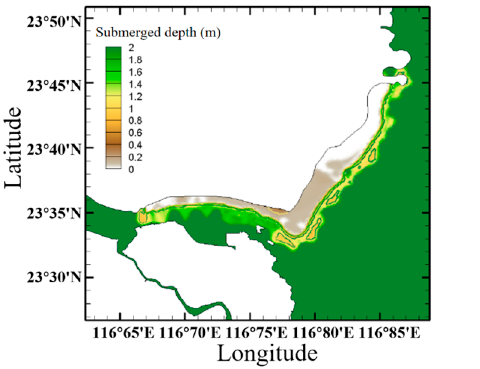
Figure 9. Blocking effect of bank on storm surge (the left picture shows the existence of bank, and the right picture shows the absence of bank).